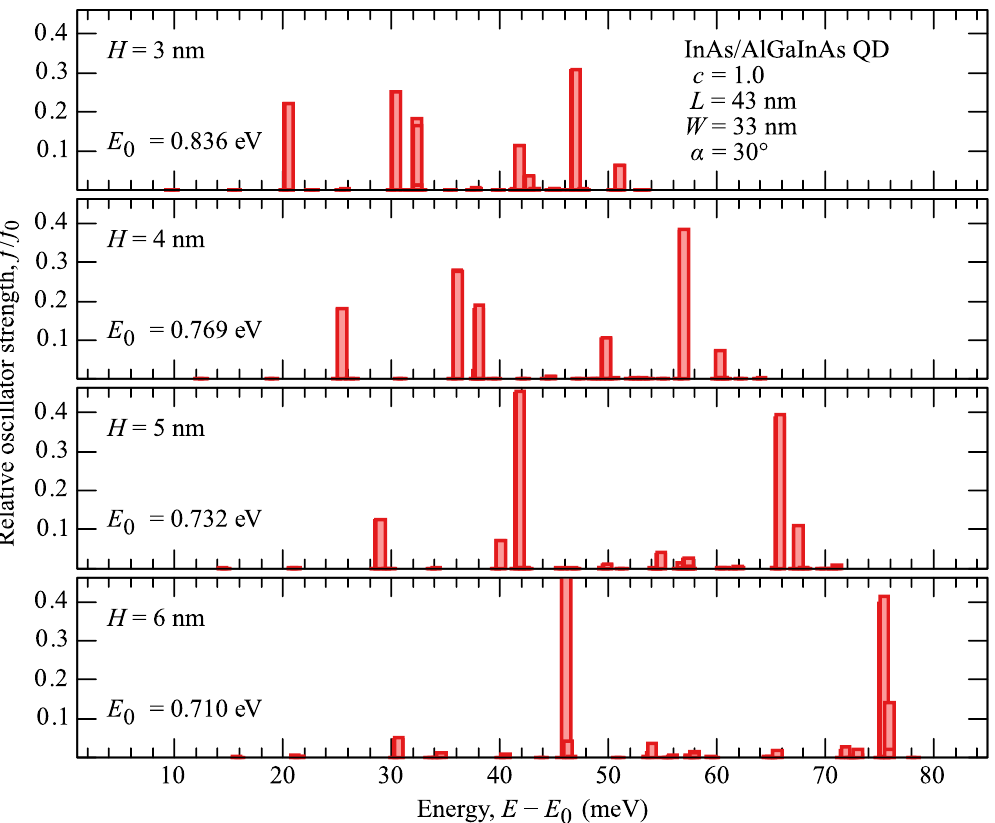
Figure 4. Impact of QD height on the exciton spectrum. Relative oscillator strength of exciton excited states as a function of their energy relative to the ground-state energy, plotted for varying height (consecutive panels) of an exemplary InAs/AlGaInAs